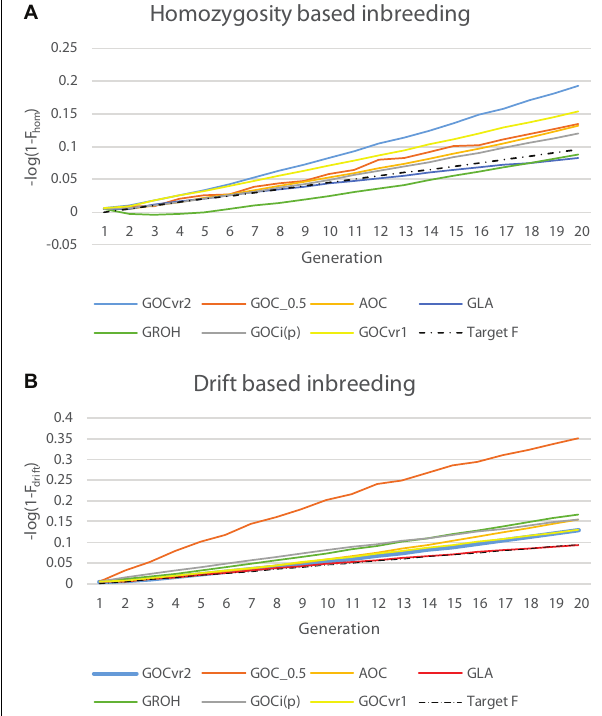
rates by 40% in both panels. This is due to the hitch-hiking of neutral loci with the changes in QTL frequencies arising from the LD generated within families and is unaccounted by using expectations of IBD based on pedigree.